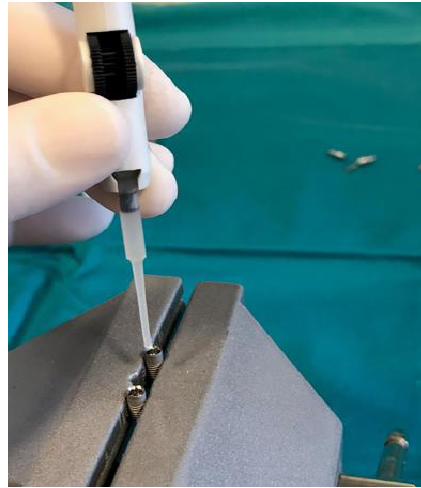
Figure 3. GapSeal gel application.